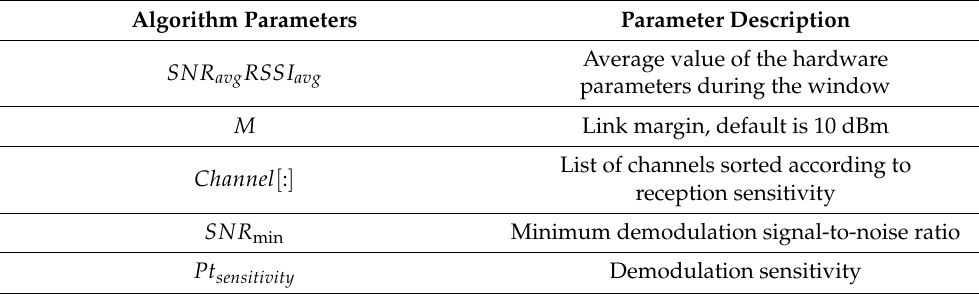
Table 4. Description of the algorithm